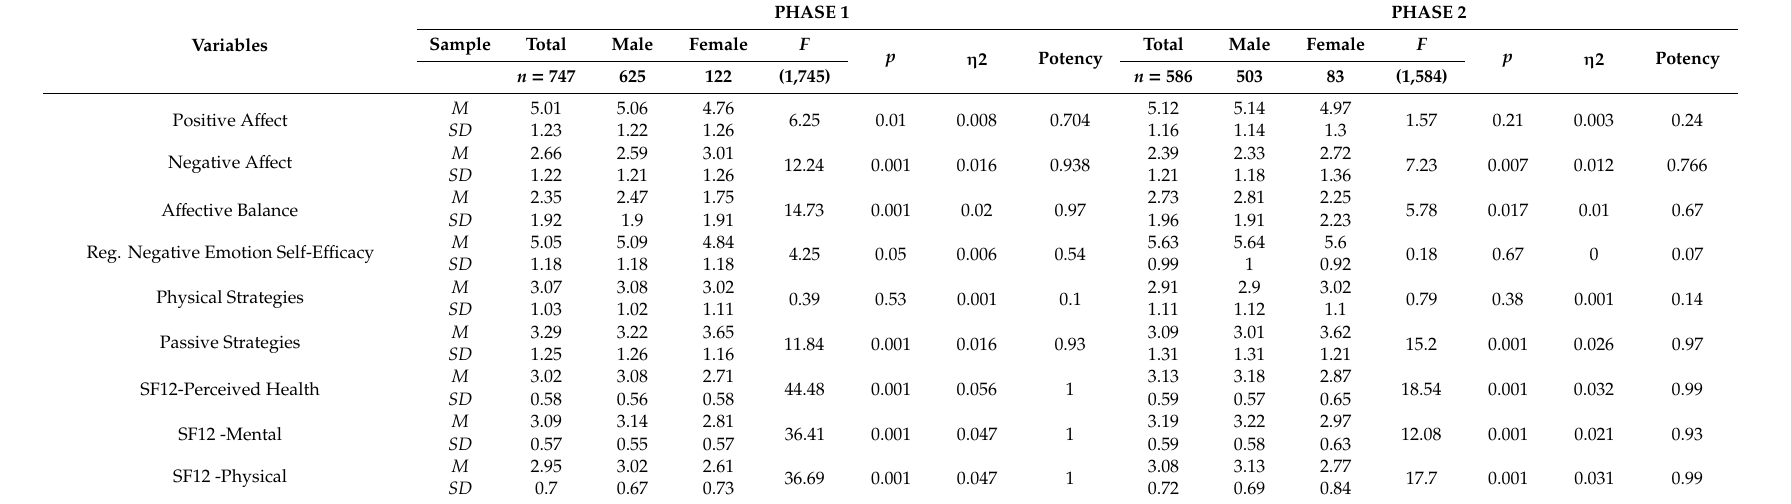
Table 3. Psychological and regulatory strategies variables of study participants by sex in phase 1 and phase